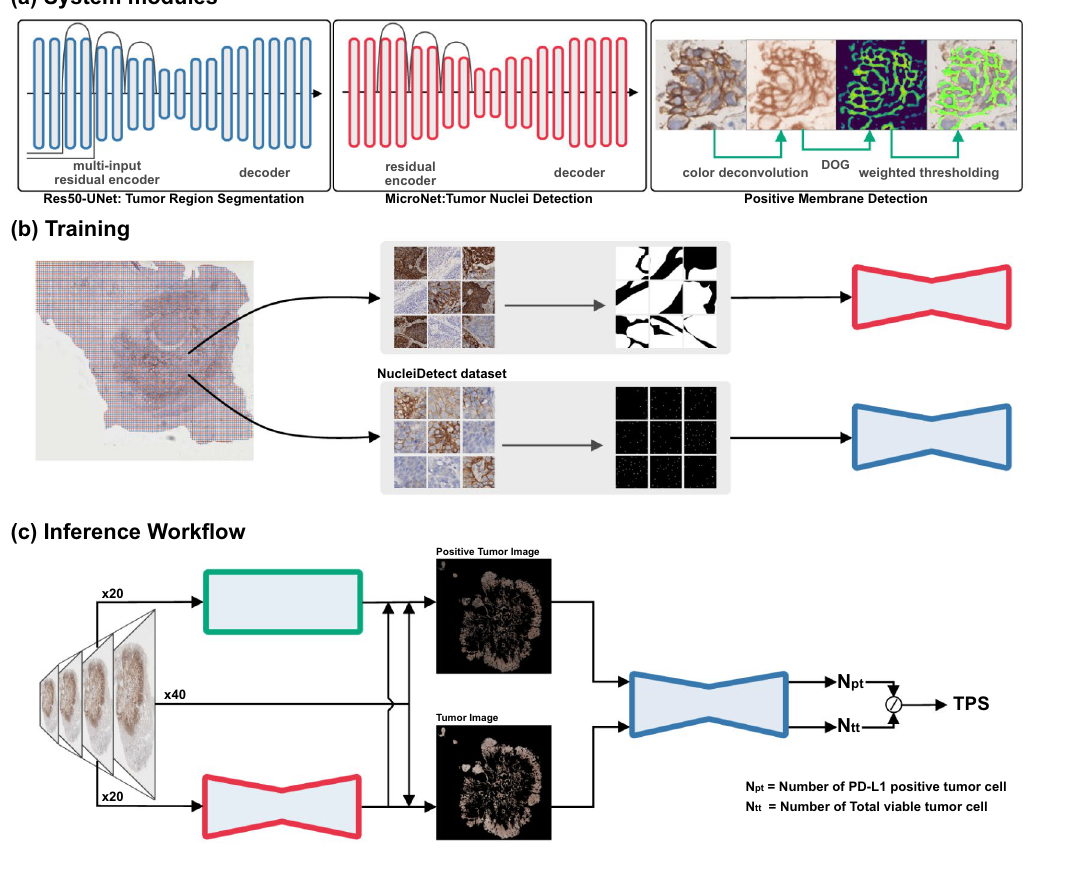
Figure 1. Overview of proposed framework in this study. ( a ) three main modules in ATPSS: tumor segmentation network (Res50-UNet), nuclei detection network (MicroNet), and positive membrane detection (PMD). ( b ) Model training. Res50-UNet and MicroNet were trained on datasets of TumorSeg and NucleiDetect respectively, which were cropped from WSI with different sizes and manually annotated by pathologists. ( c ) WSI inference workflow. A whole-slide image at 20 × resolution is fed into the trained Res50-UNet and PMD module to get the masks of tumor region and positive tumor region. N pt and N tt were predicted by MicroNet based on those two masked whole-slide images with 40 × resolution, and finally the tumor proportion score is